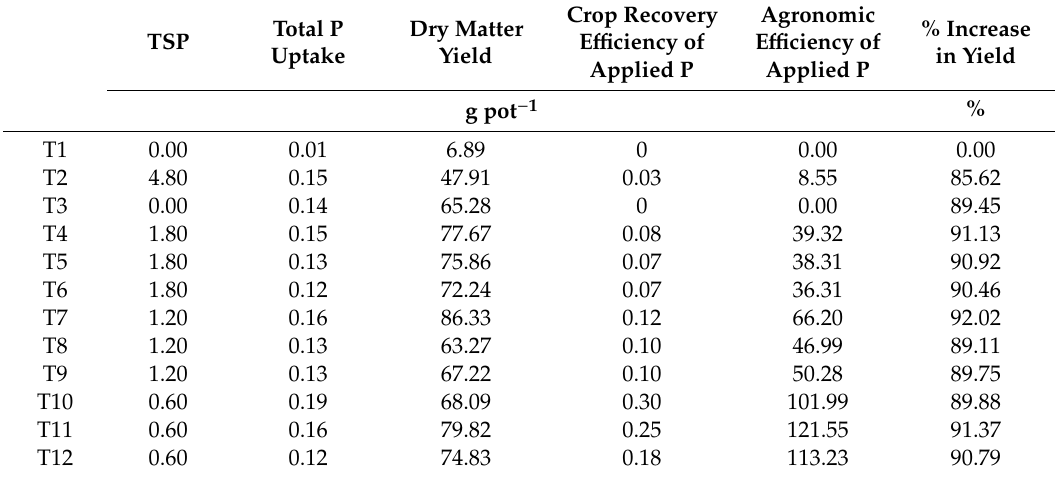
Table 10. E ff ects of treatments on crop recovery and agronomic e ffi ciency of applied phosphorus at tasseling stage of maize plants. Crop Recovery Agronomic Total P Dry Matter % Increase TSP E ffi ciency of E ffi ciency of Uptake Yield in Yield Applied P Applied P g pot −